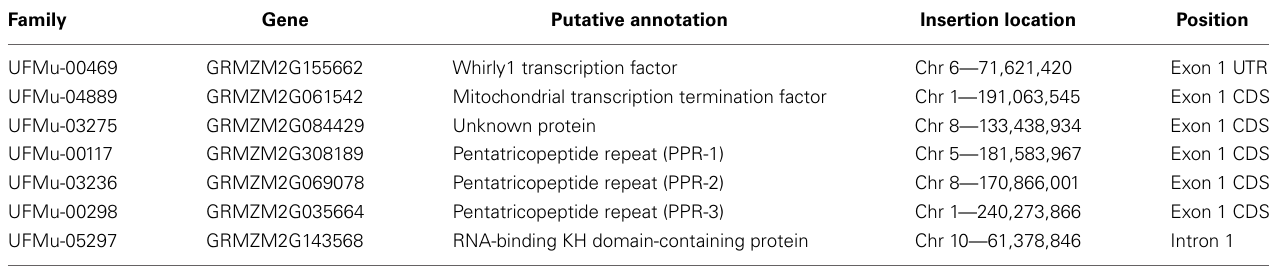
Table 2 | Putative causal genes identified by forward-genetic Mu-seq.